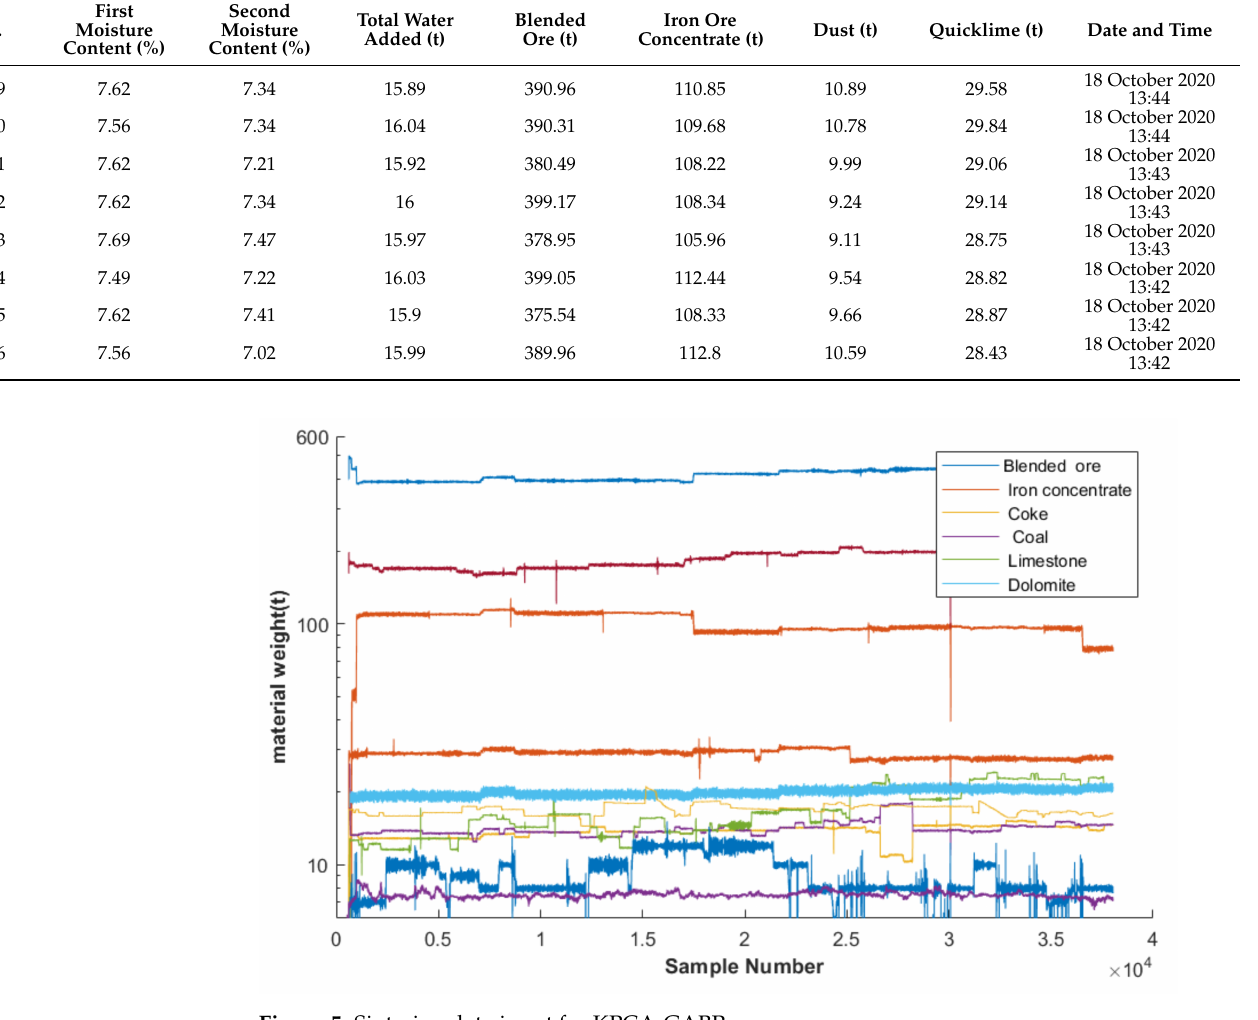
Figure 5. Sintering data input for